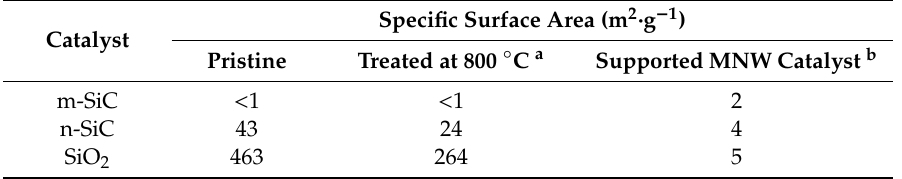
Table 1. Specific surface areas of supports and supported Mn 2 O 3 -Na 2 WO 4